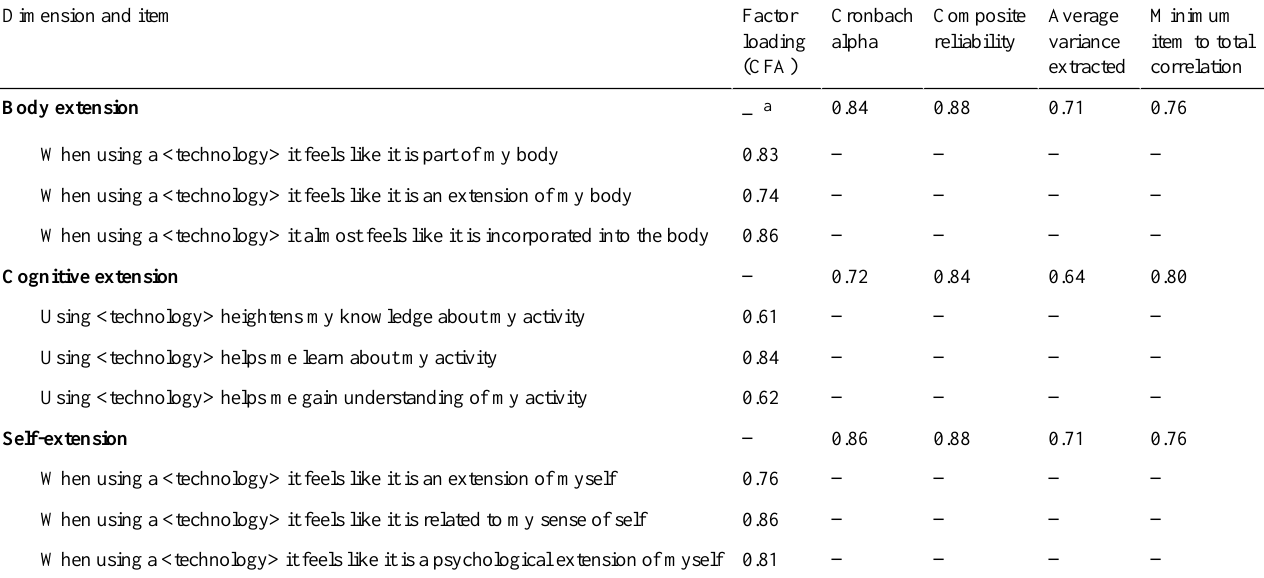
Table 4. Convergent validity: Factor loadings, Cronbach alphas, composite reliabilities, (average variance extracted), and minimum item to total